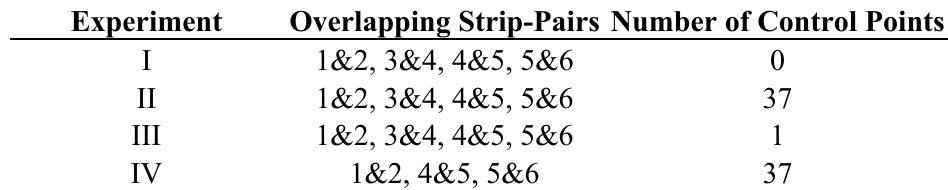
Table 1. Experiments description (used overlapping strip-pairs and number of control points).